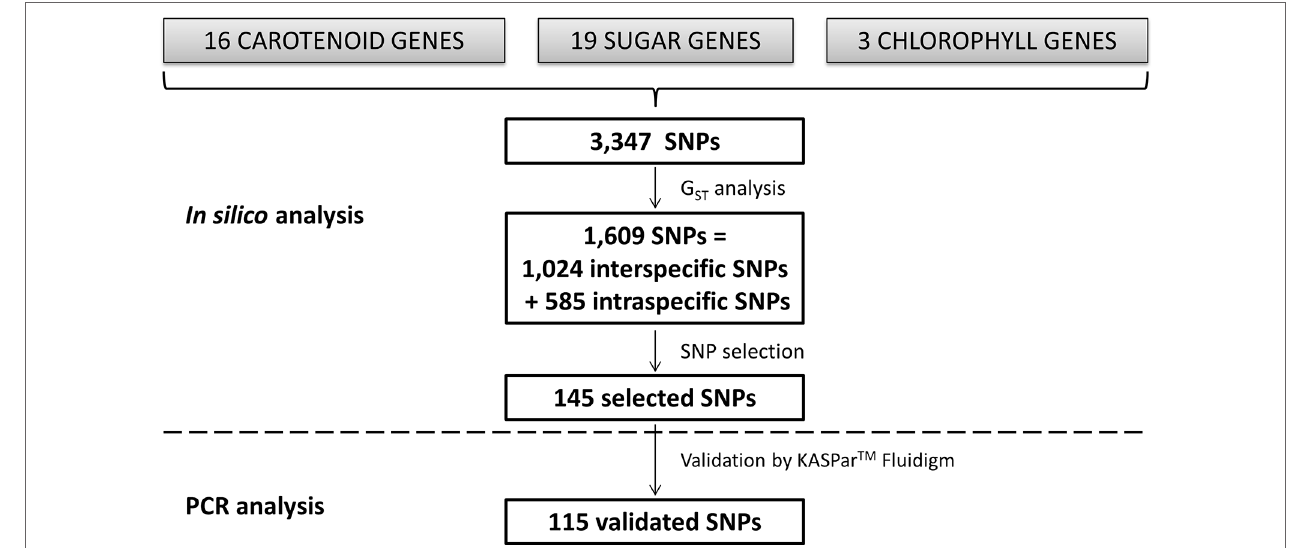
FIGURE 1 | Scheme of the in silico analysis leading to SNP identification and KASPar ™